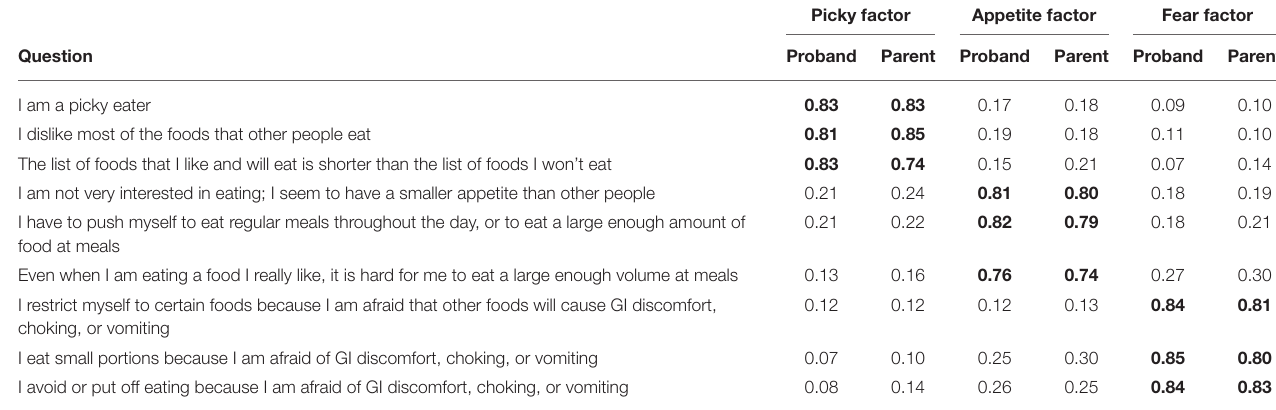
TABLE 1 | Factor loadings on the